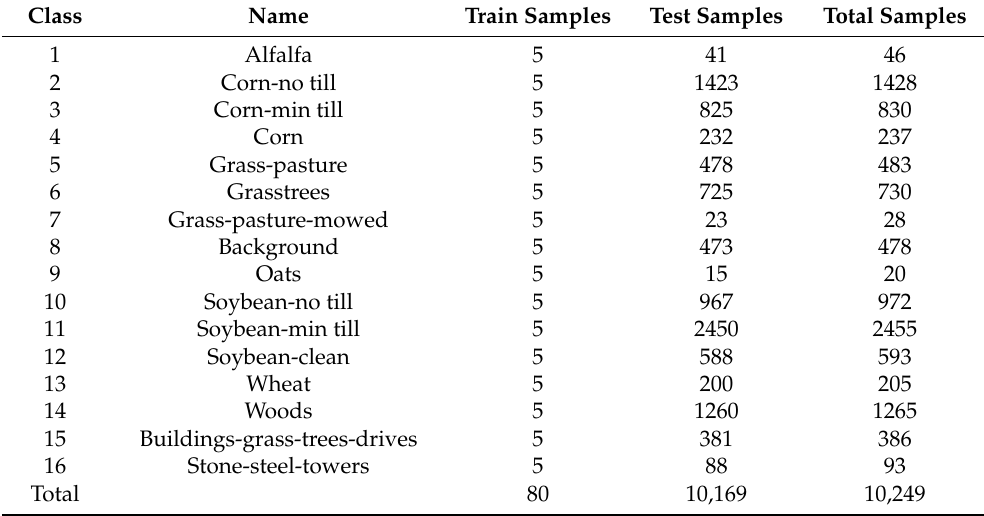
Table 1. The number of samples used for training and testing in the IP dataset.